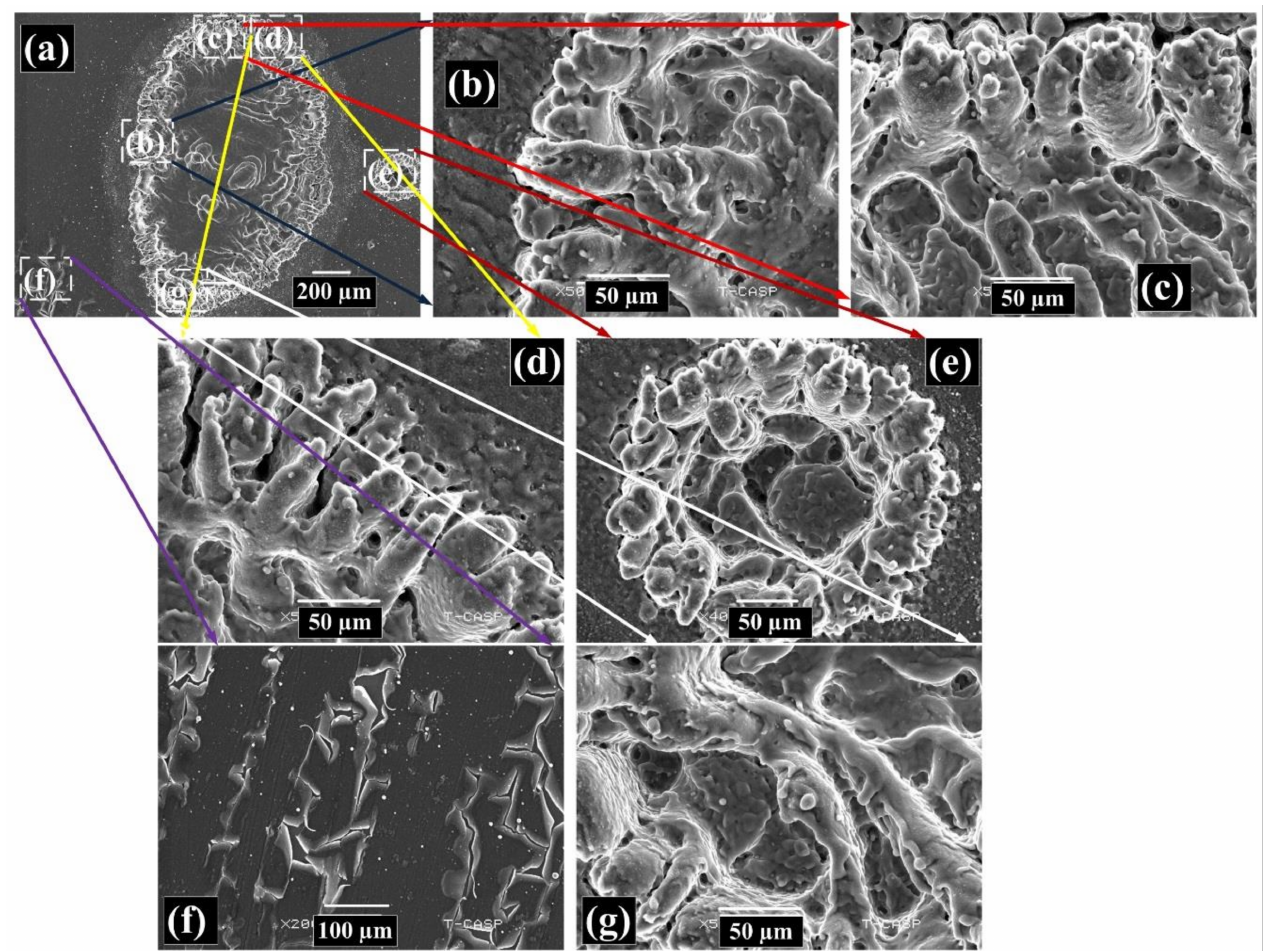
Figure 13. SEM images revealing the surface morphology of laser-irradiated Mg at constant pressure of 5 Torr of Ne gas and laser irradiance of 2.0 GW/cm 2 in the presence of a magnetic field, where ( a ) the surface structure at the boundaries of the laser ablated-crater of the Mg alloy, ( b – d ) sample micro-sized conical spikes and cavities in the periphery areas, ( e ) A top view of conical spikes, ( f ) flakes at the lower boundary of the ablated crater, and ( g ) non-uniform melting and resulting dendritic